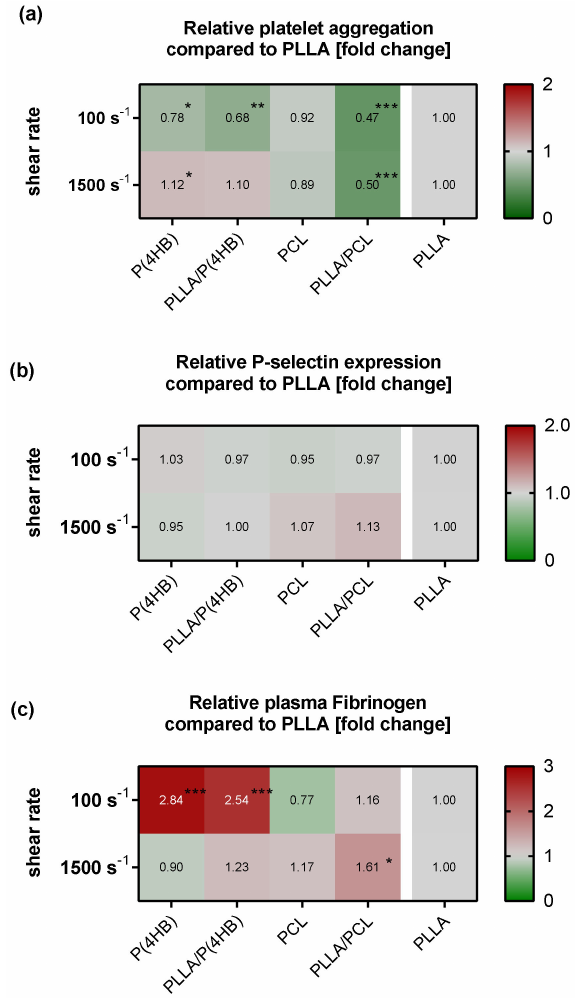
Figure 2. Material characteristics alter platelet response to polymers. Human platelets were circulated through a parallel plate flow chamber system, containing either no polymer or the indicated materials, for 5 min with shear rates of 100 s − 1 and 1500 s − 1 : ( a ) After flow exposure, collagen-induced platelet aggregation was measured. ( b ) Subsequent FACS analysis was performed immediately after flow exposure. Therefore, PRP was collected and platelets were stained for P-selectin. ( c ) PRP was collected for ELISA measurement of soluble fibrinogen. To visualize the effect of the different polymers, heat maps show the relative mean of at least five independent experiments compared to PLLA. Significances with regard to PLLA are indicated, with * p < 0.05, ** p < 0.01 and *** p <